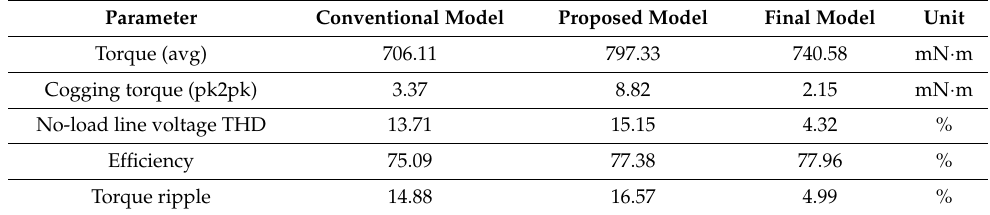
Figure 17. Torque ripple with D tap (4000 rpm).